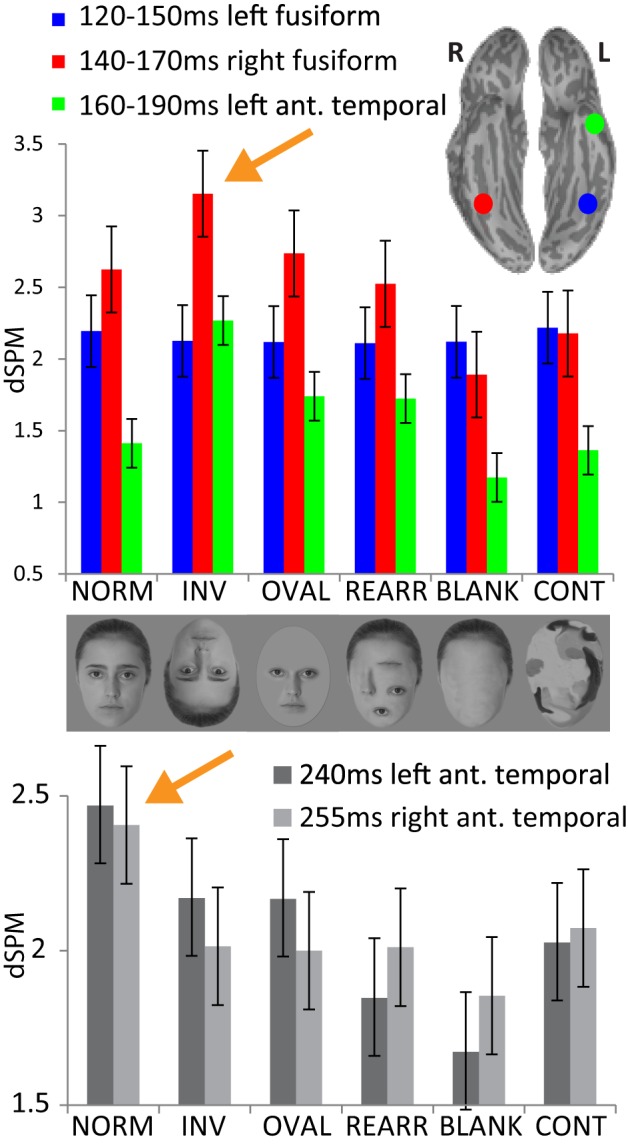
Upper panel: group average noise-normalized dipole strengths expressed as dSPM F-values for the ROIs in the fusiform cortex bilaterally and in the left anterior temporal area representing the successive processing stages: no activity difference in the left fusiform 120–150 ms across conditions; strongest activity to inverted faces in the right fusiform (140–170 ms) and in the left anterior temporal area (160–190 ms). Lower panel: noise-normalized peak amplitude dipole strength estimates in the anterior temporal areas bilaterally within 220–270 ms. Normal, upright faces elicit the strongest activity in both hemispheres, possibly reflecting acquired familiarity processing.